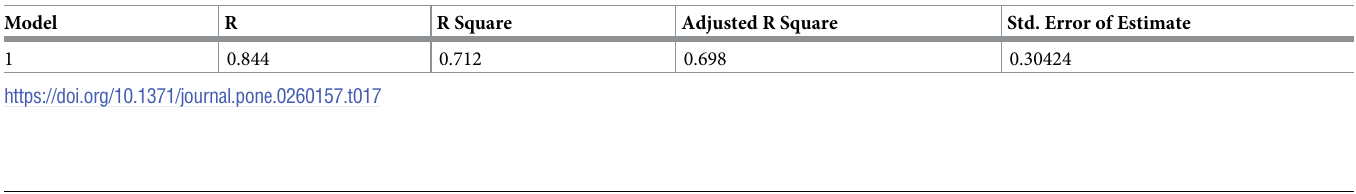
Table 17. Regression